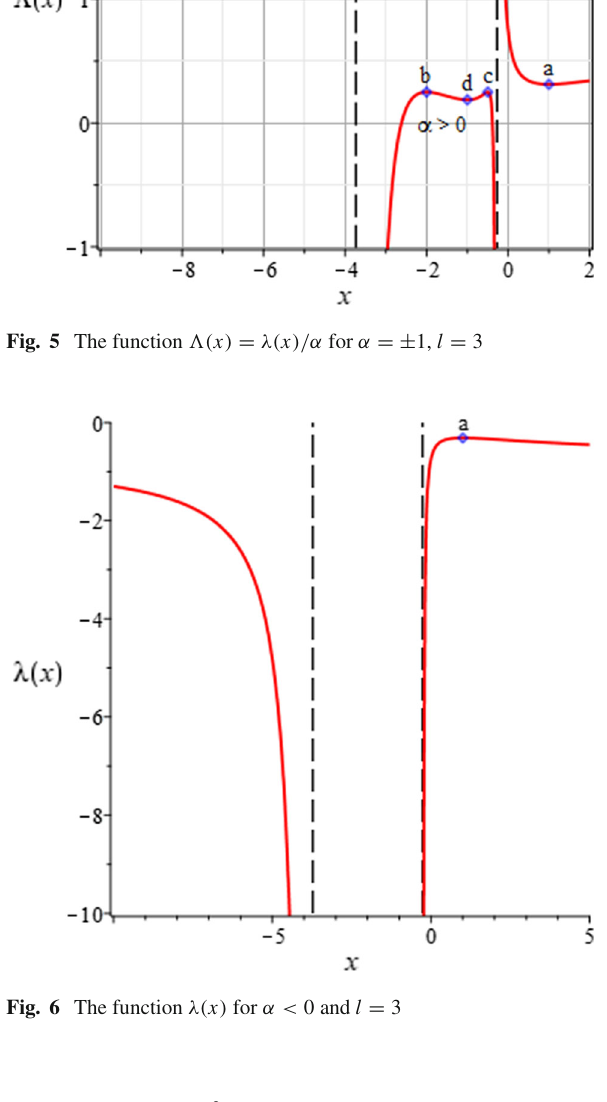
(3.32) and Proposition 1 the function (cid:2)( x ) | α | = − λ( x ) is monotonically increasing: in the interval ( −∞ , x − ) from = 1 , +∞ ) from − λ ∞ to +∞ and in the interval ( x a + 0 to − λ ∞ . It is monotonically decreasing in the − λ for l > 2. The graphical representation of functions (cid:2)( x ) = a (cid:2)( x , α) = λ( x )/α for α = + 1 , − 1, respectively, and l = 3 interval ( x + , x a ) from +∞ to − λ a + 0. Here x a is a point is given at Fig. 5. of local minimum of the function (cid:2)( x ) | α | = − λ( x ) and < − λ ∞ . The last relation (inequality) may be verified − λ The function λ( x ) for α < 0 and l = 3 is presented at Fig. a explicitly. Indeed, due to relations (3.23), (3.49) we obtain